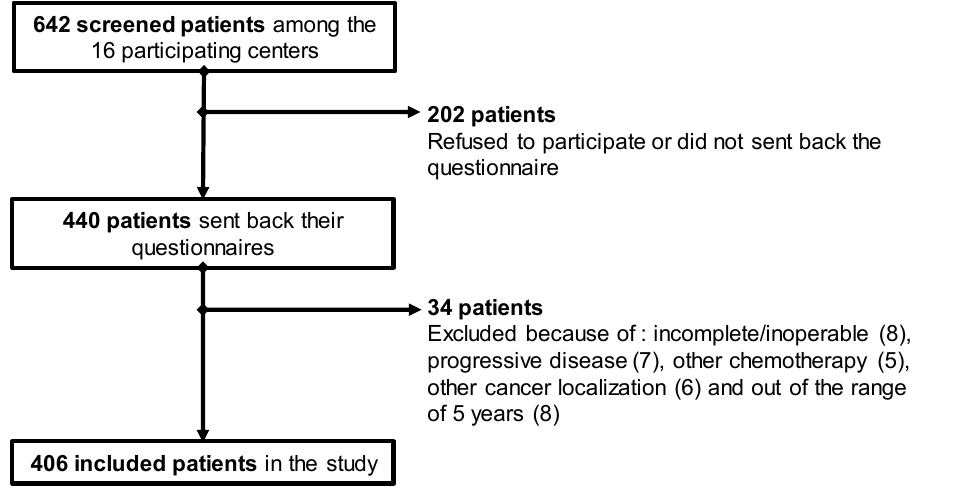
Figure 1. Flowchart of patient inclusion. Table 1. Characteristics of the included patients ( n = 406). Categorical variables are expressed as percentages (number). Continuous variables are expressed as mean ± standard deviation (* p <